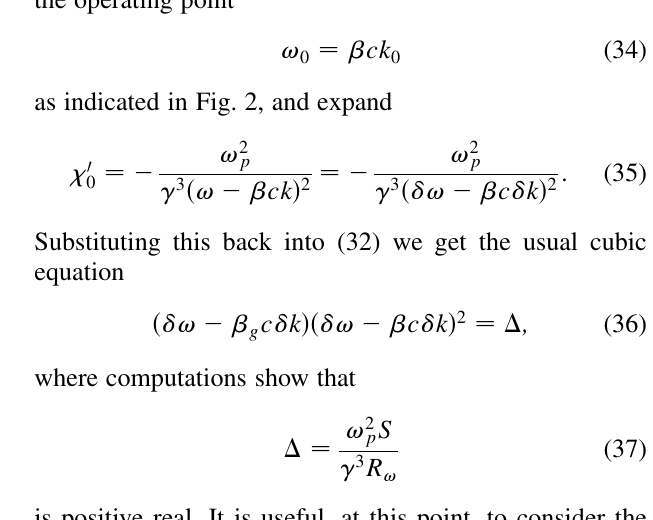
FIG. 2. Dispersion diagram calculated for the Dartmouth